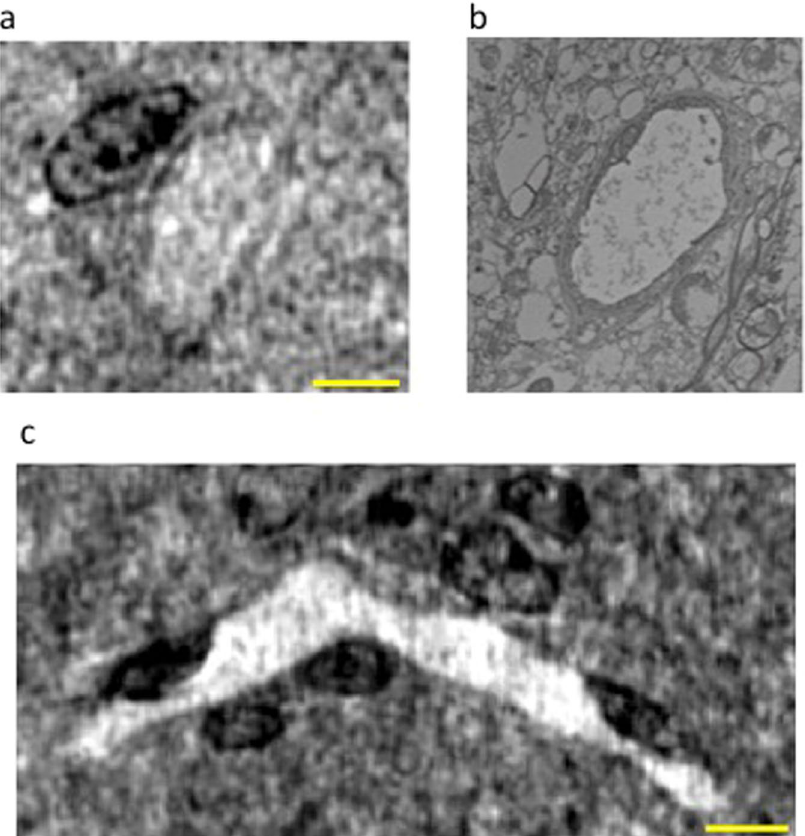
Figure 3. Nano-XPCT of capillaries in EAE spinal cord samples. Images of a transversal section (130 nm thick) were obtained by ( a ) XPCT and ( b ) TEM. ( c ) XPCT image of the longitudinal section of a capillary in a 20 μ m- thick virtual slice. Samples were obtained at 5 dpo. Scale bar: 8 μ